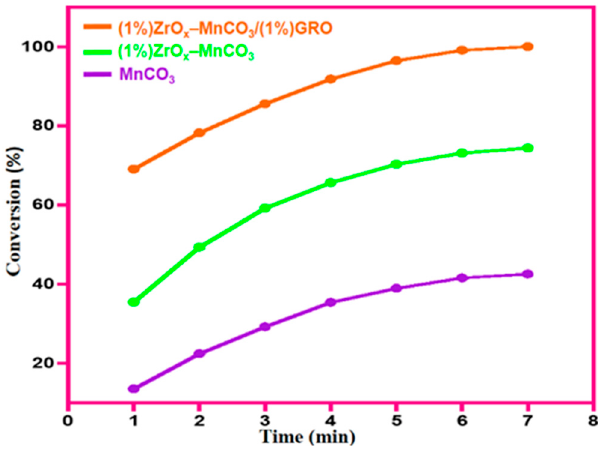
Figure 8. Influence of reaction time (min) on the catalytic activities of the as-prepared catalysts.